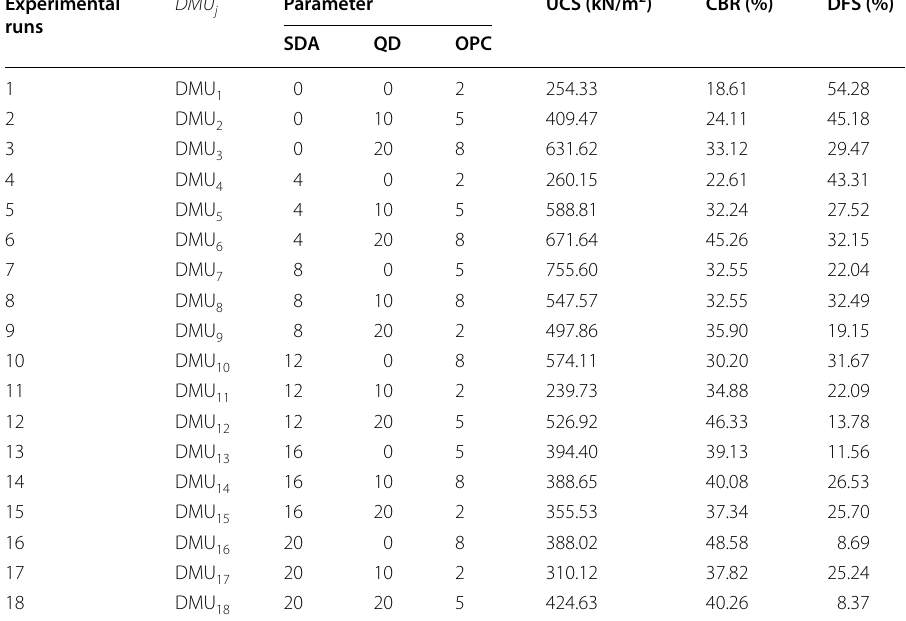
Table 6 Mean response